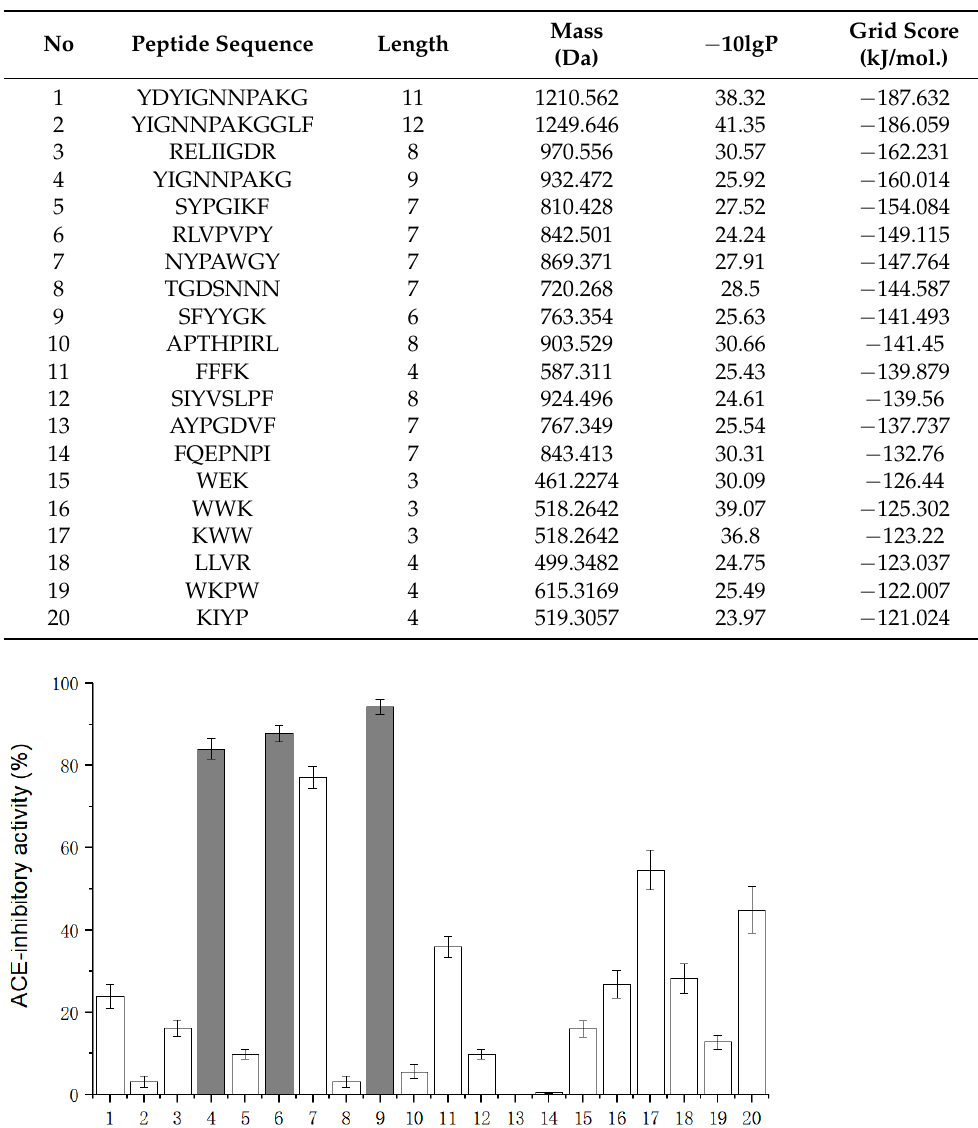
Table 1. The 20 peptides with the highest grid score by virtual screening.